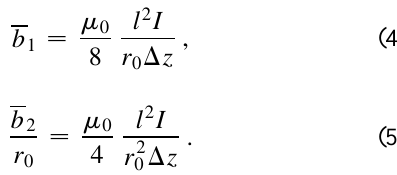
TABLE I. Physical and magnetic parameters of PC dipoles and quadrupoles for the UMER. Design algorithm Eq. (3) with n (cid:1) 1 Radius and length ( r 0 , (cid:1)